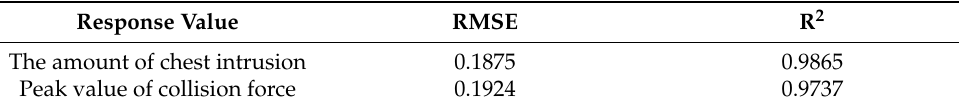
Table 4. The RMSE and R 2 of ARBF model at convergence.